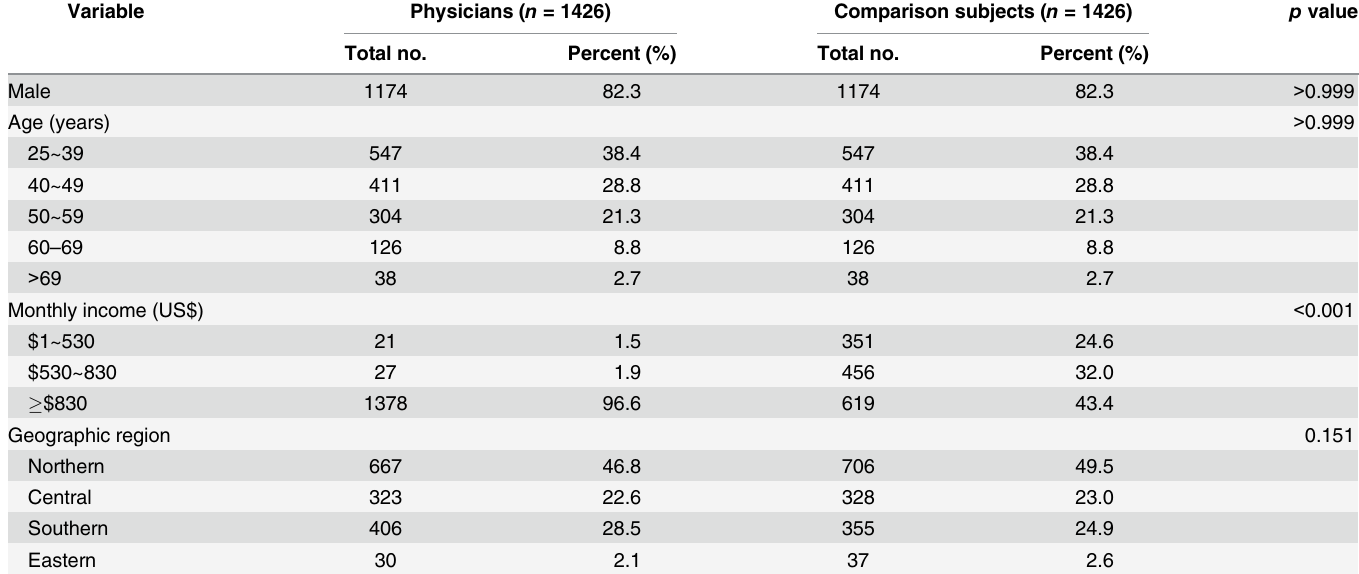
Table 1. Demographic characteristics of physicians and comparison subjects ( n =